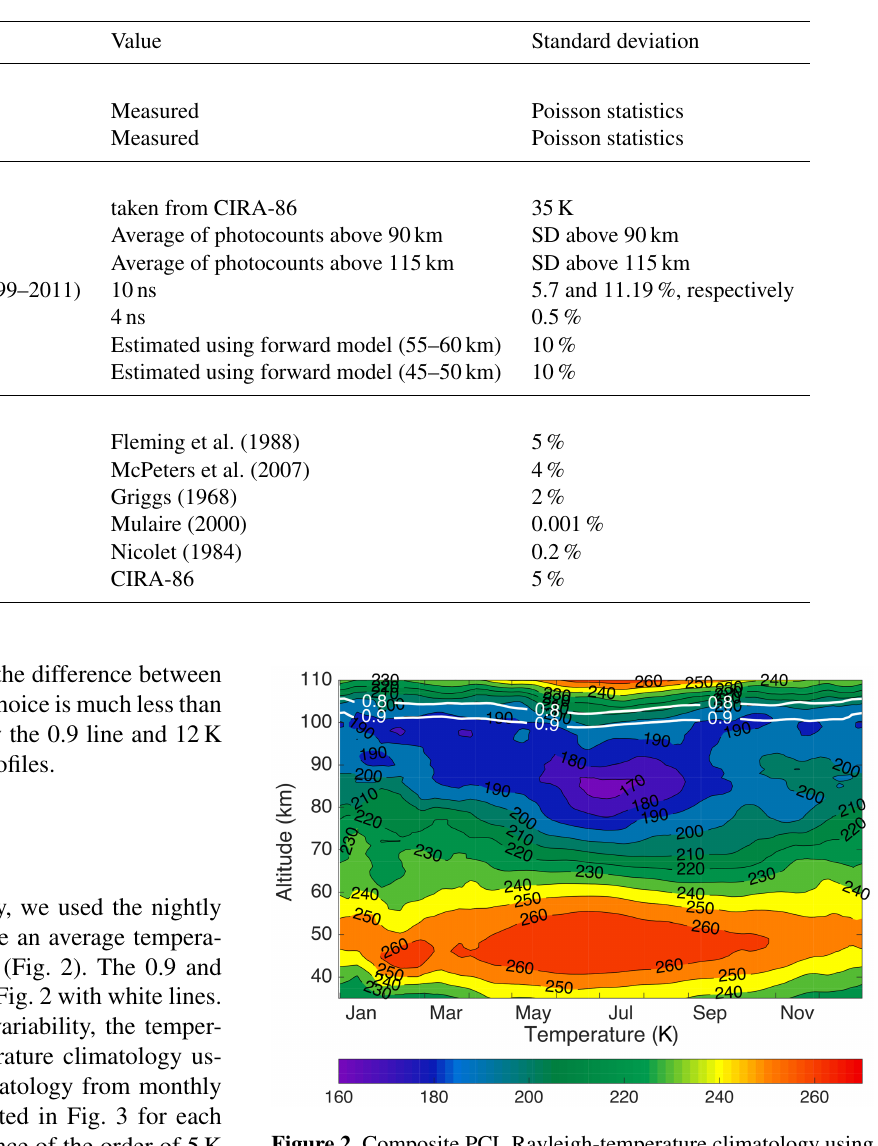
Figure 2. Composite PCL Rayleigh-temperature climatology using the OEM. The white lines are the height below which the tempera- ture climatology is more than 90% (0.9) and 80% (0.8) due to the